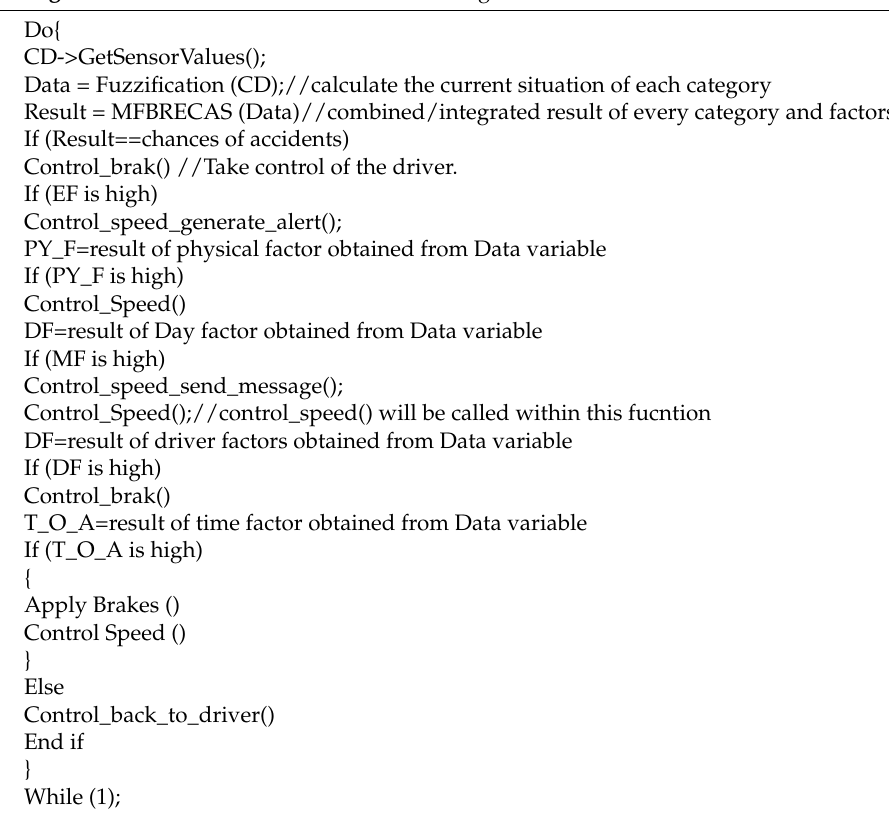
Algorithm 1: Control Structure for transferring vehicle control to and from